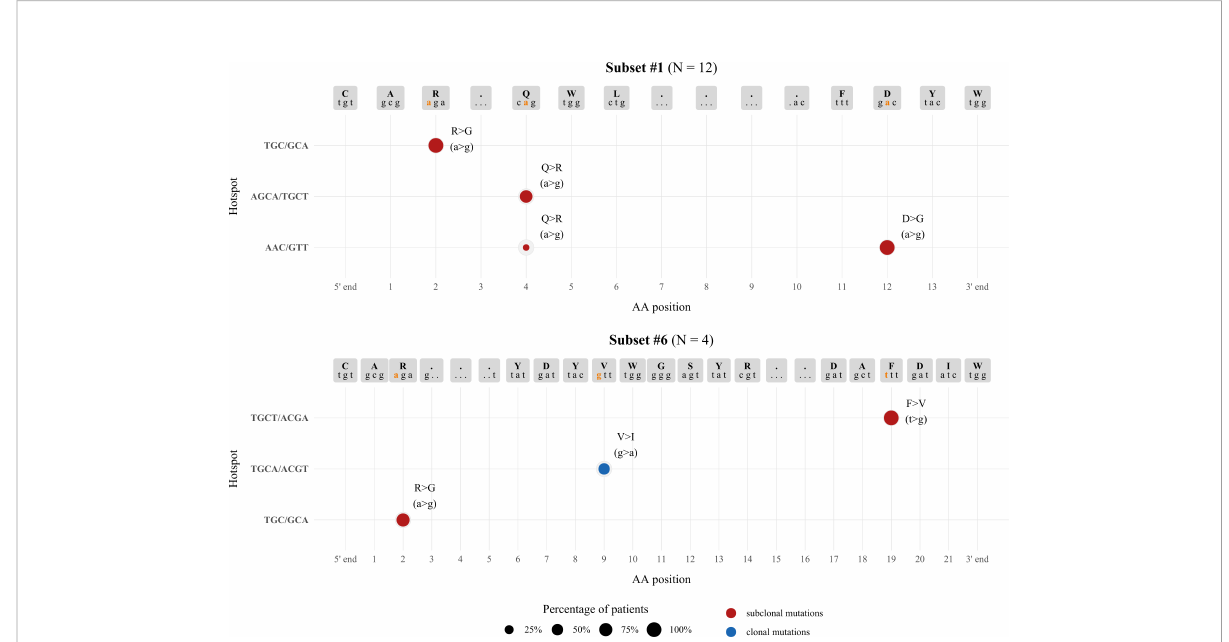
FIGURE 4 Topology of SHMs observed within the VH CDR3 in relation to AID hotspots. The size of each node represents the percentage of patients exhibiting a particular SHM, while the graph coordinates of each node correspond to the AID hotspot involved in each SHM. Different colors are used to distinguish between clonal (blue) and subclonal (red)